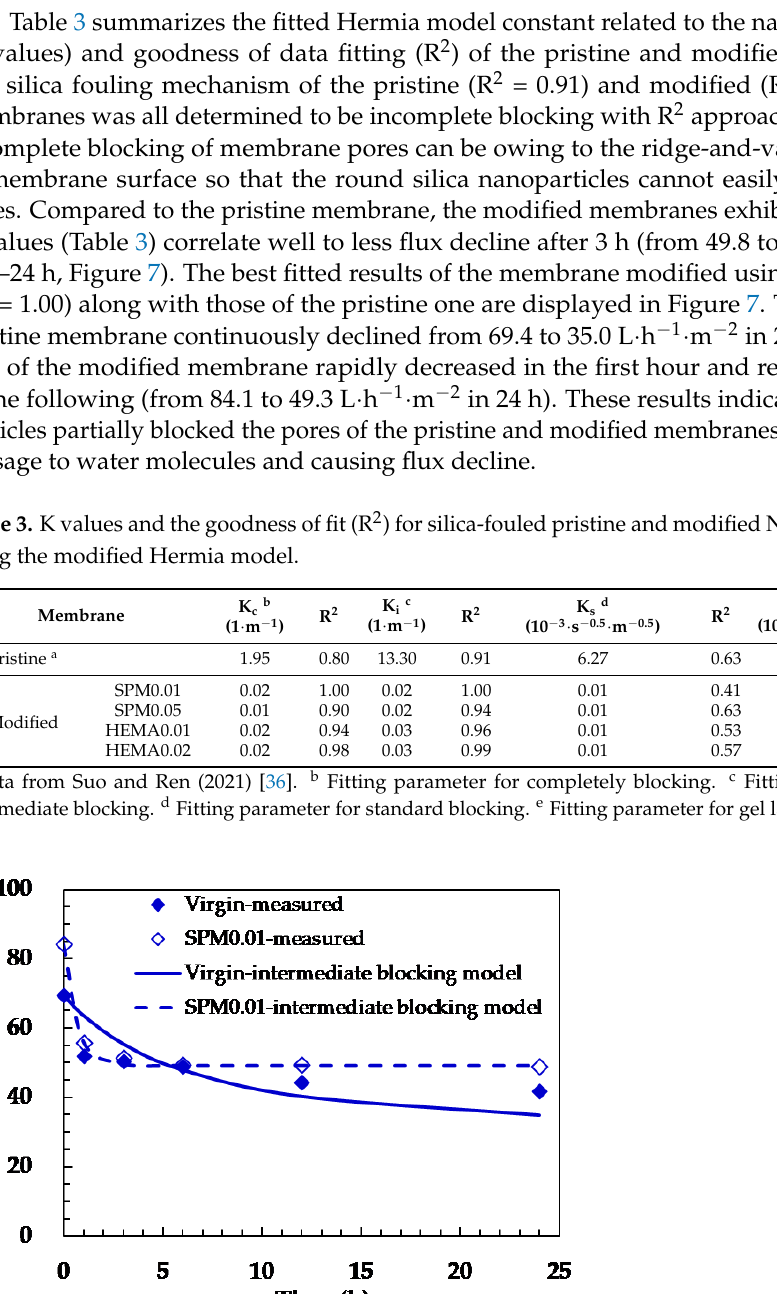
Figure 7. Experimental and model predicted flux as a function of time for the pristine and 0.01 M SPM modified NF90 during silica fouling. (L · h − 1 · m − 2 Table 3. K values and the goodness of fit (R 2 ) for silica-fouled pristine and modified NF90 deter- mined using the modified Hermia model.